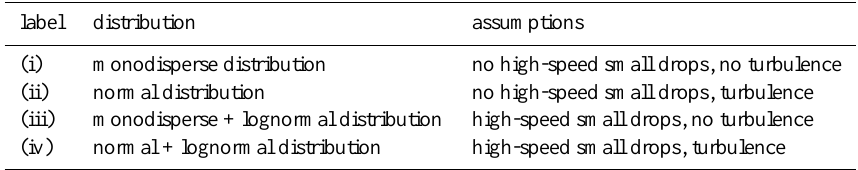
Table 1. Distributions of velocity ratios used throughout this paper, with the corresponding assumptions regarding the presence of the effects of high-speed small drops and turbulence-induced variations in fall